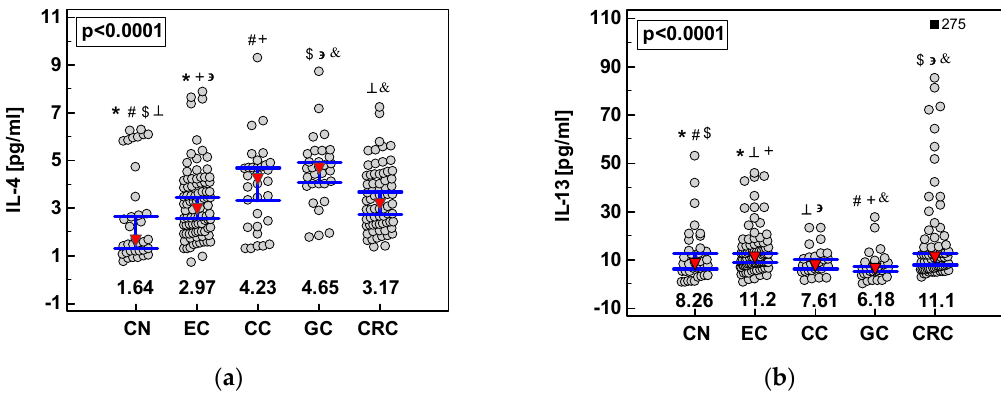
Figure 9. Systemic concentration of interleukins in gastrointestinal tract cancers: ( a ) IL-4; ( b ) IL-13. Data presented as medians (red triangles) with 95% confidence interval (whiskers) and analyzed using Kruskal-Wallis H test. Statistically significant differences between groups are marked with symbols of the same type (*, #, etc.). CN, healthy controls; EC, patients with esophageal squamous cell carcinoma; CC, patients with adenocarcinoma of gastric cardia; GC, patients with gastric adenocarcinoma; CRC, patients with colorectal cancer. An outlying observation is marked by a closed square.